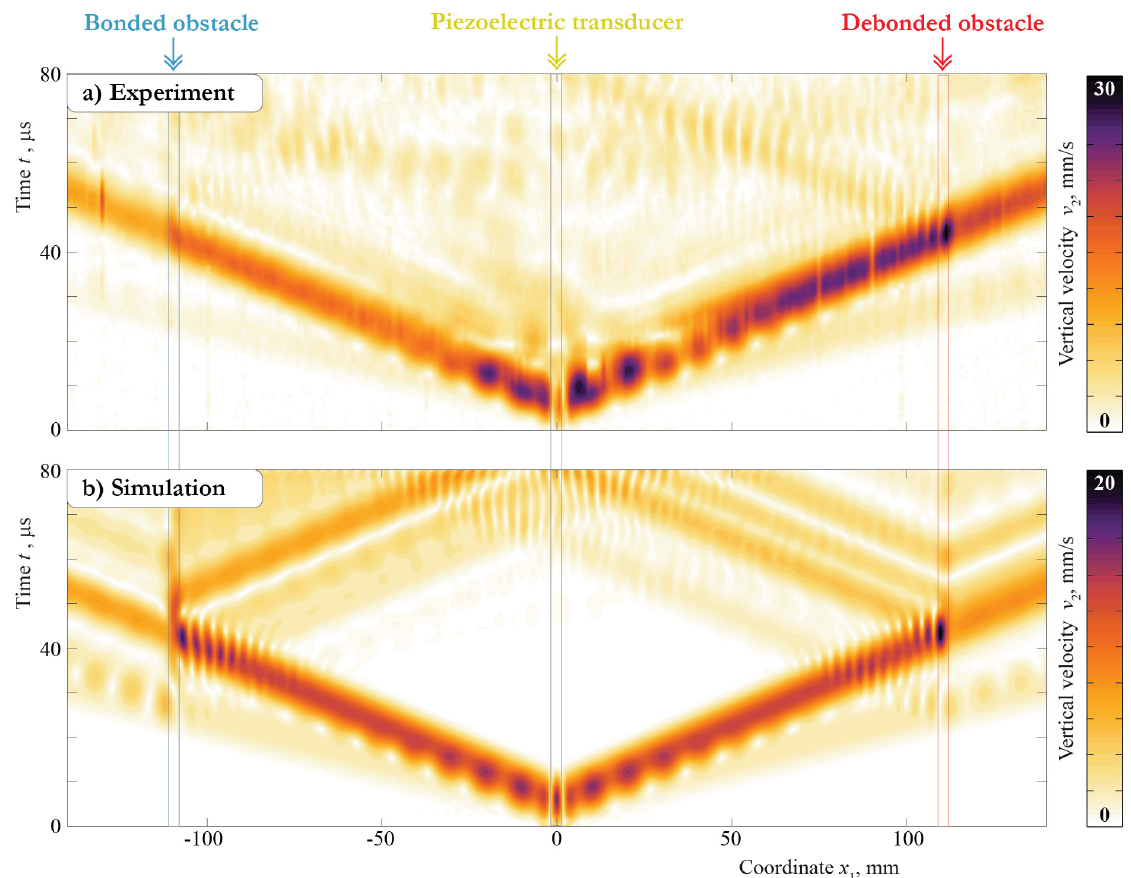
Figure 7. Vertical velocities at the surface of the plate for bonded ( a ) and debonded ( b ) obstacles measured and calculated with the central frequency f = 300